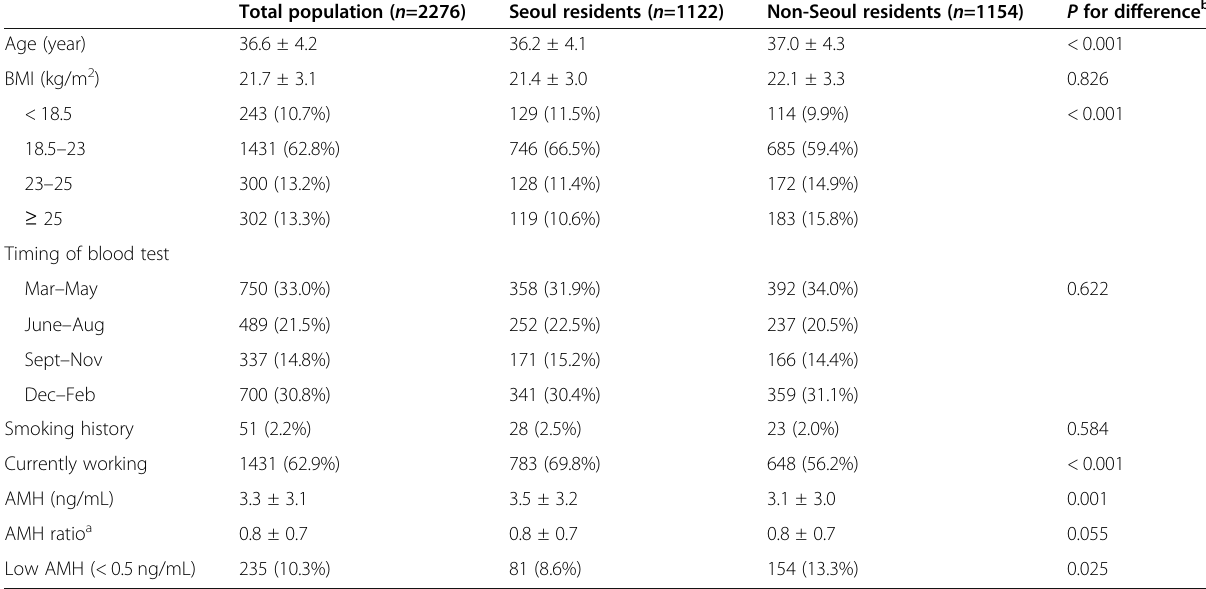
Table 1 Demographic and clinical characteristics and anti-Müllerian hormone (AMH) of the study population, total population ( n = 2,276), Seoul ( n =1,122), and non-Seoul ( n =1,154)